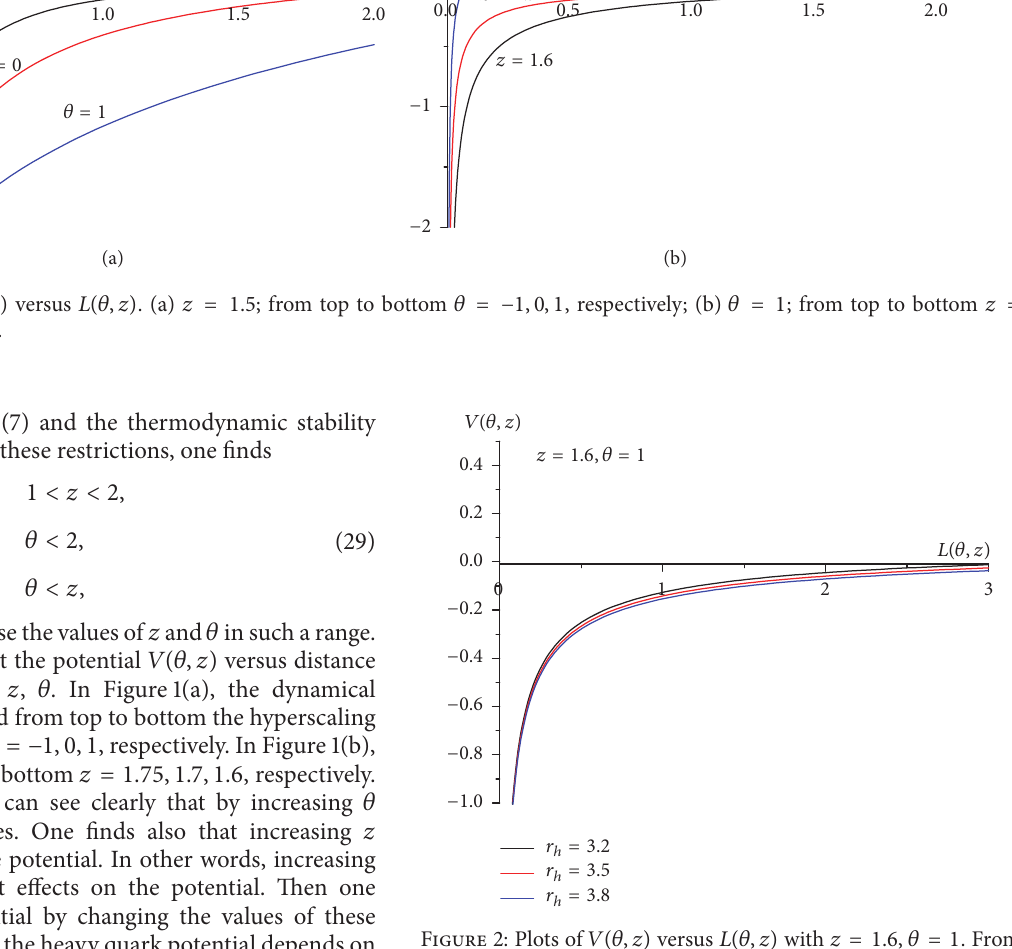
Figure 2: Plots of 𝑉(𝜃, 𝑧) versus 𝐿(𝜃,𝑧) with 𝑧 = 1.6 , 𝜃 = 1 . From top to bottom 𝑟 ℎ = 3.2, 3.5, 3.8 ,